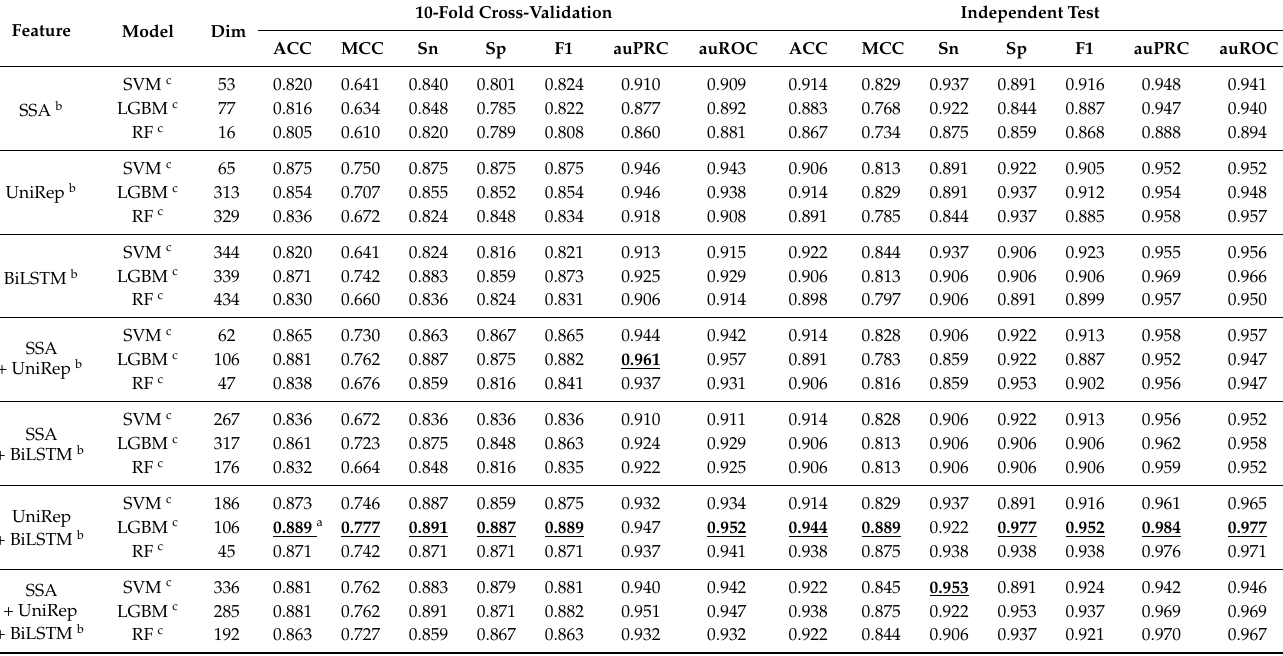
Table 3. Performance metrics of individual features and fused features, according to the machine learning methods used to derive